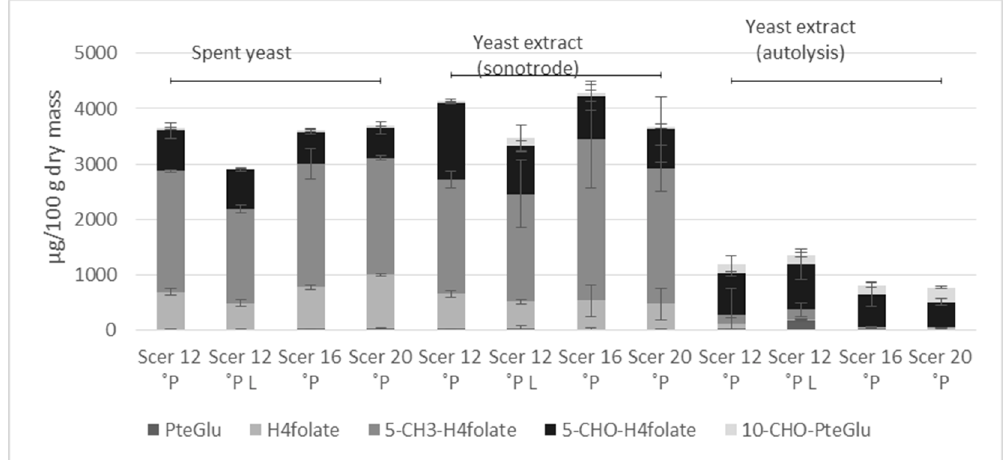
Figure 6. Distribution of the folate vitamers 5-CH 3 -H 4 folate, 5-CHO-H 4 folate, 10-CHOPteGlu, H 4 folate and PteGlu in spent yeast ( S. cerevisiae TUM 68) and in the corresponding yeast extract (via sonotrode or autolysis); influence of original gravity (12 ˚ P, 16 ˚ P, 20 ˚ P), time of yeast cropping (after primary fermentation vs. after cold beer lagering (L)); for results of the pairwise t-test, see text; data are expressed as mean values ± confidence limits.